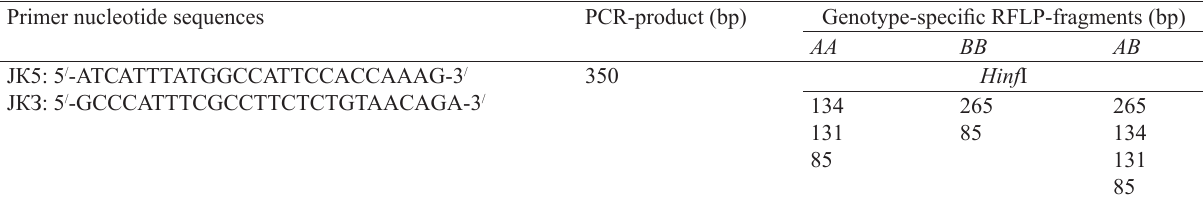
Table 2 Genotyping primers for the CSN3 A and B alleles generated PCR products and RFLP fragments Primer nucleotide